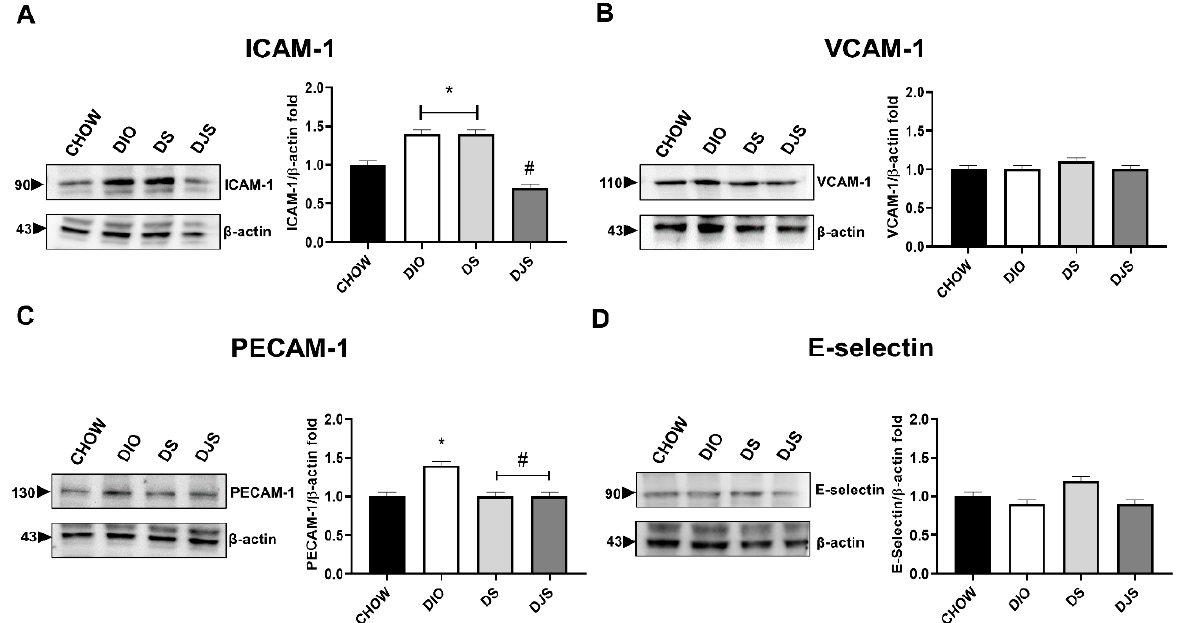
Figure 5. Western blot analysis of inflammatory adhesion molecules. Cardiac lysates were im- munoblotted using antibodies against intracellular adhesion molecule-1 (ICAM-1) ( A ); vascular cell adhesion molecule-1 (VCAM-1) ( B ); platelet endothelial cell adhesion molecule-1 (PECAM-1) ( C ); E-selectin ( D ). Graphs show the densitometric ratios of bands and β -actin expression used to nor- malize the data. CHOW rats ( n = 8), reference group fed with standard diet; DIO rats ( n = 9), fed with high-fat diet; DS ( n = 12), DIO rats supplemented with tart cherry seeds; DJS ( n = 9), DS rats supplemented with tart cherry juice. Data are mean ± SEM. * p < 0.05 vs. CHOW rats; # p < 0.05 vs. DIO rats.